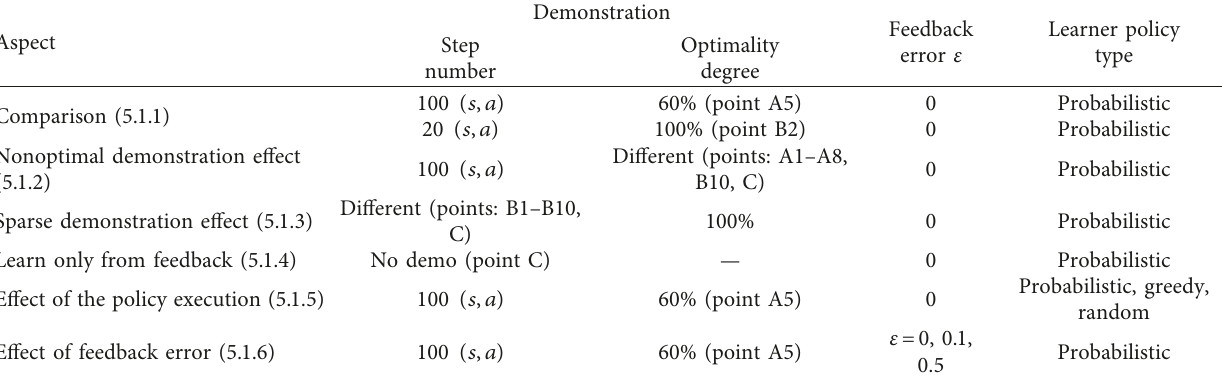
Table 2: Setting used to study different aspects of our framework (IRLDC) in the simulated navigation domain.